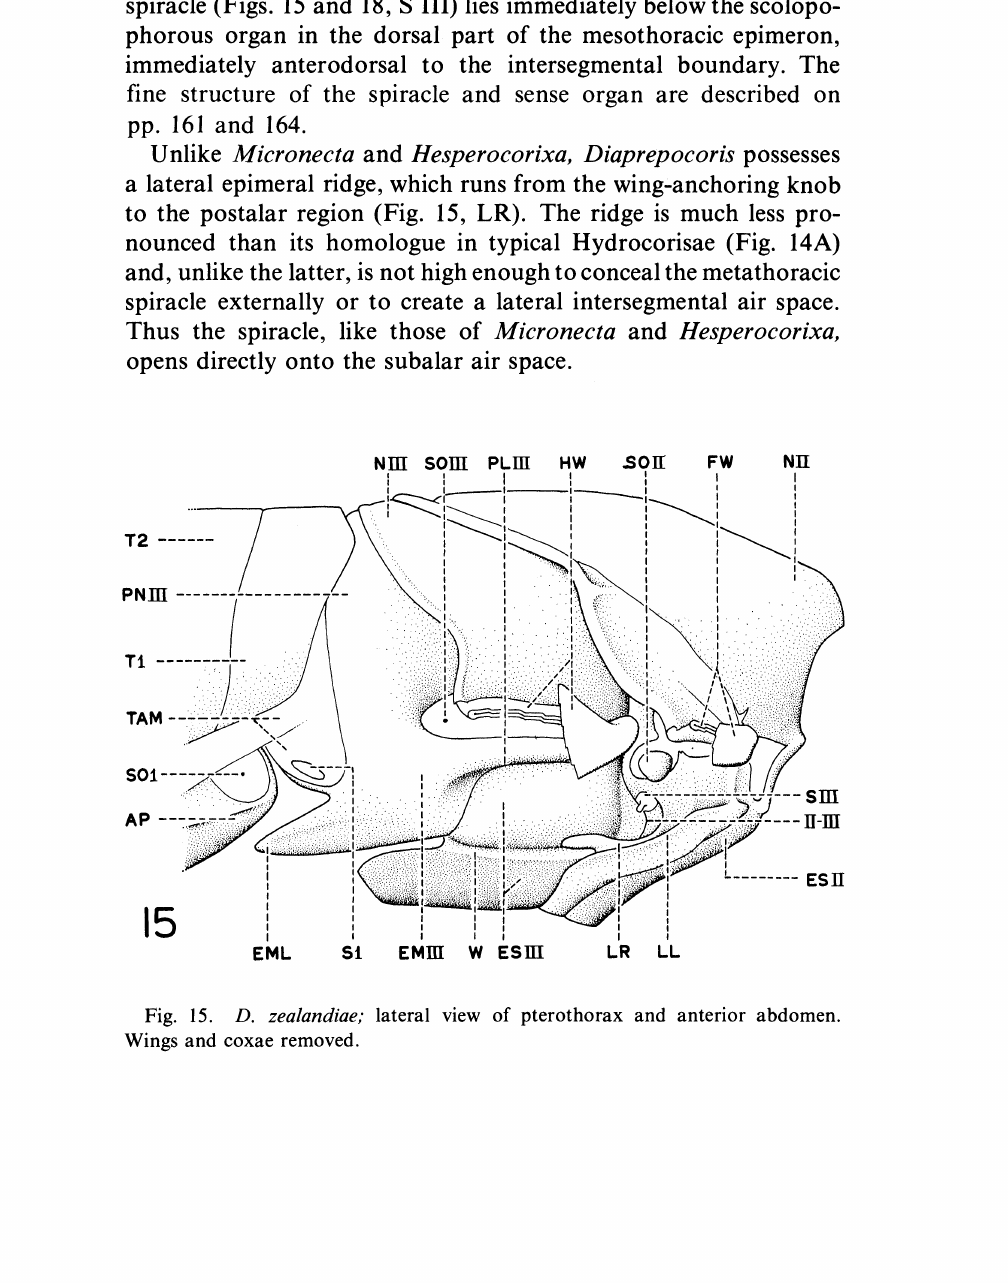
Fig. 15. D. zealandiae; lateral view of pterothorax and anterior abdomen. Wings and coxae